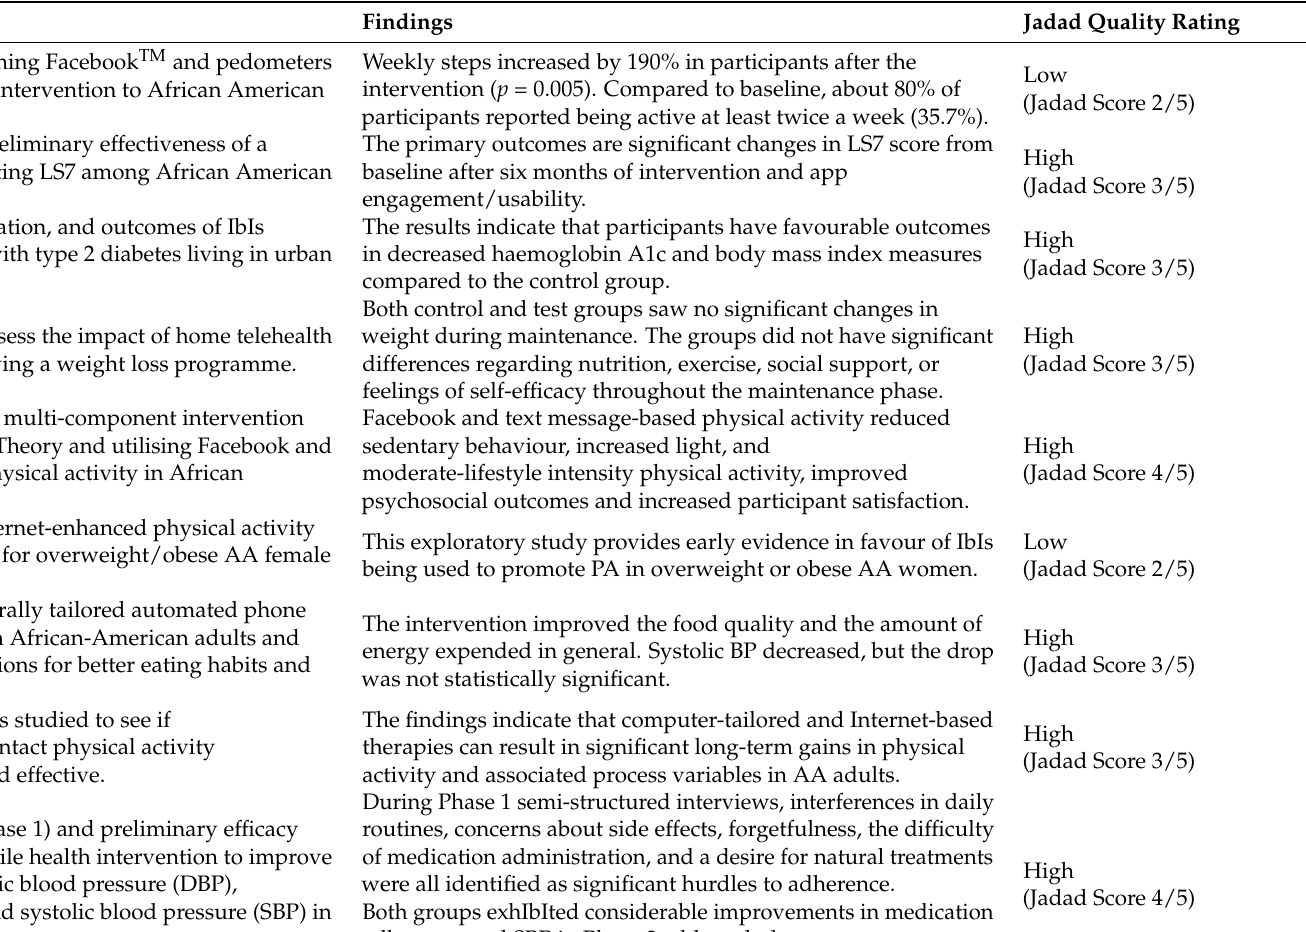
Table 4. Summary of Study Outcomes and